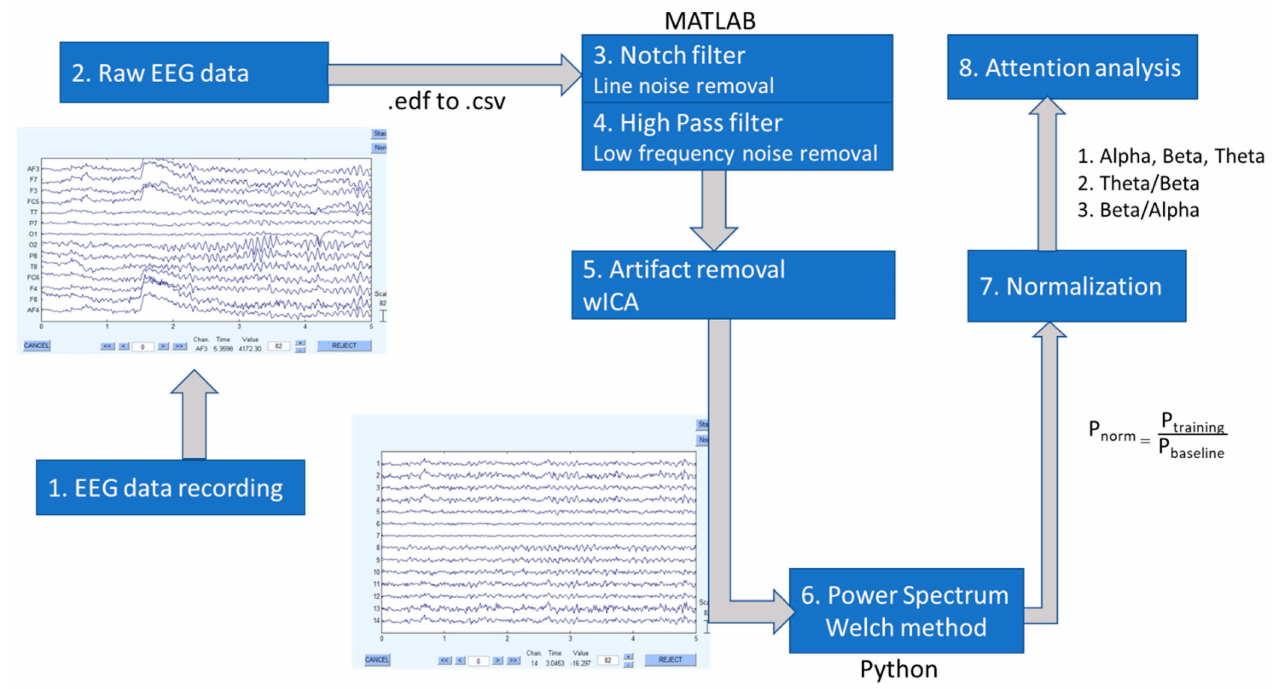
Figure 5. Data-processing steps for EEG